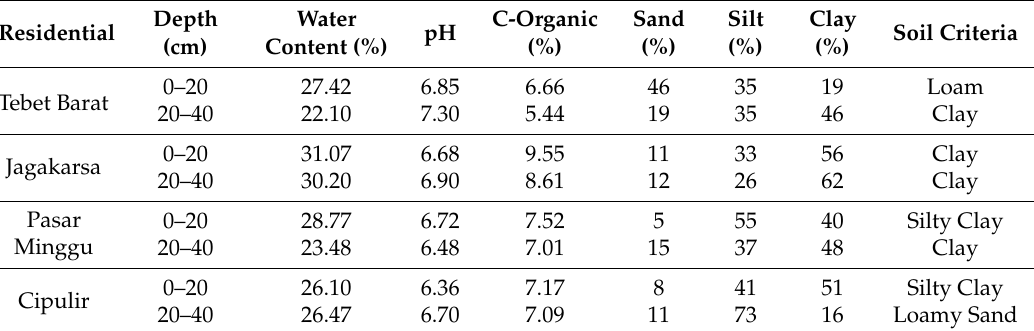
Table 2. Soil characteristics at four residences in South Jakarta.